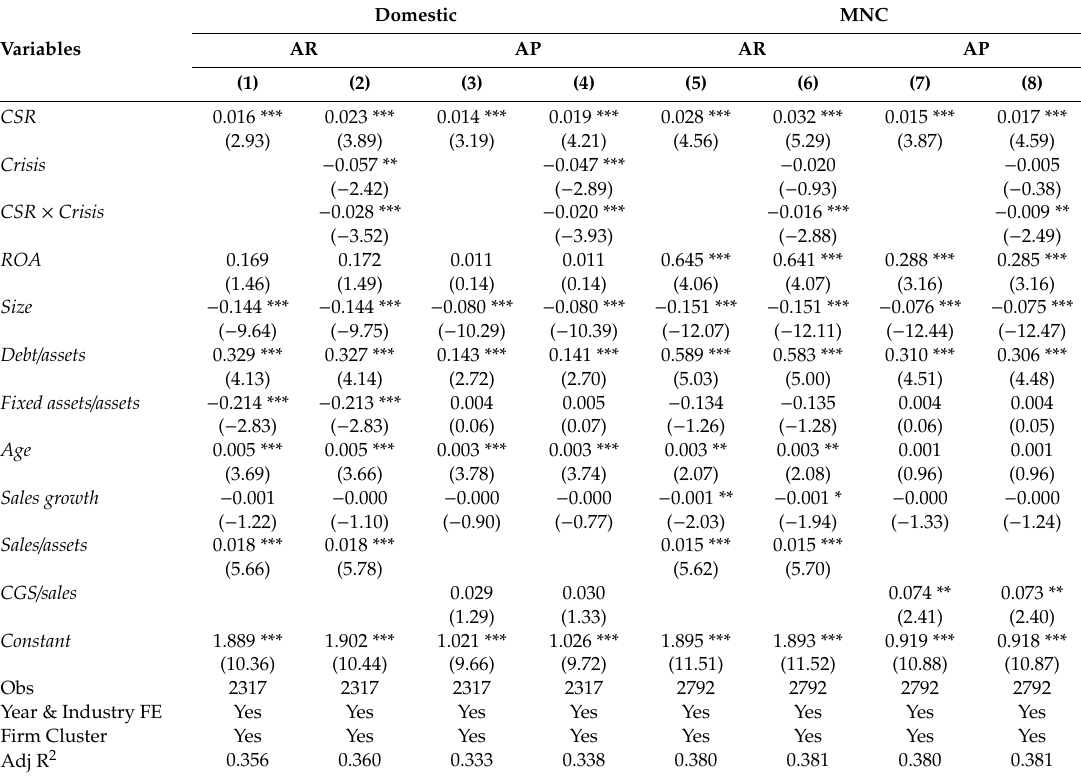
Table 10. Domestic vs. multinational corporations